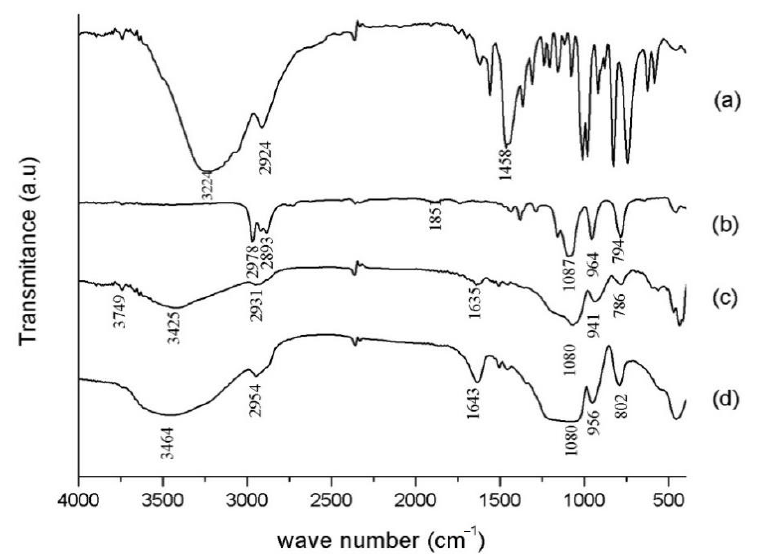
Figure 2. FTIR spectra of ( a ) 2,2 furildioxime (FDO), ( b ) tetraethoxysilane (TEOS), ( c ) TEOS-FDO and ( d ) TEOS-FDO-Ni 2+ .